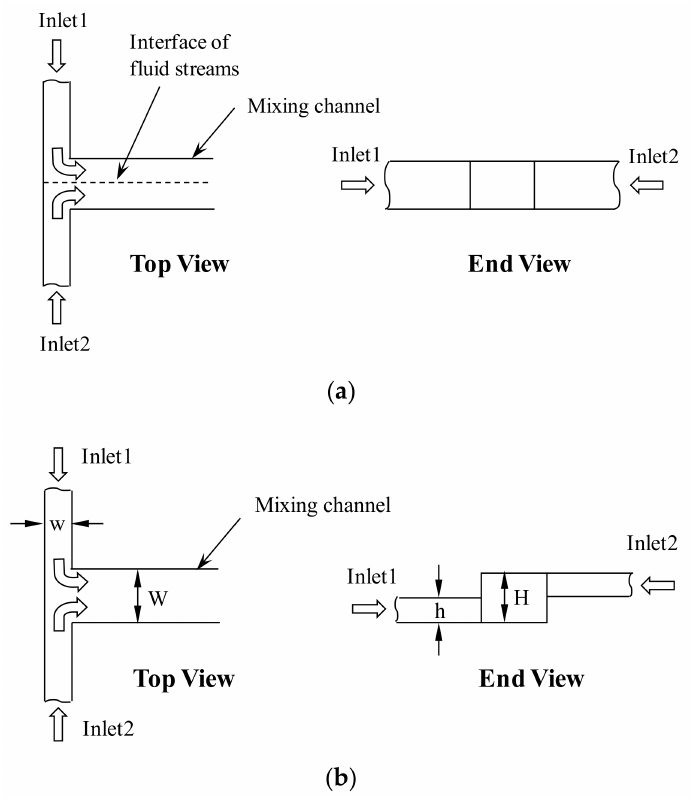
Figure 2. Schematic of the basic idea of the micromixer: ( a ) simple T-mixer and ( b ) vortex micro